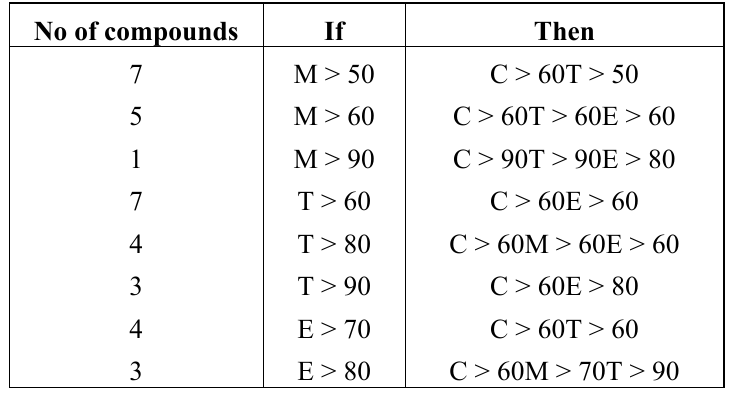
Table 9 . Selected implication sets from the formal concept analysis of human health effects by 1,1-dimethyl hydrazine and its transformation products as derived by PASS [35].